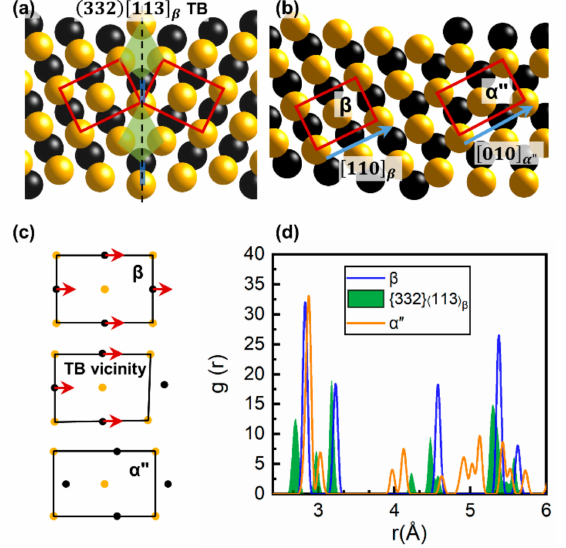
Figure 5. The illustration of α ” formation through atom collective displacements. The local atomic configurations of { 332 }(cid:104) 113 (cid:105) β TB ( a ), β and α ” ( b ). ( c ) The displacements of atoms projected on the (cid:16) (cid:17) 110 plane for the formation of α ” phase in β phase and at { 332 }(cid:104) 113 (cid:105) β TB. ( d ) The radial distribution β functions of β phase, the local region of { 332 }(cid:104) 113 (cid:105) β TB and α ”